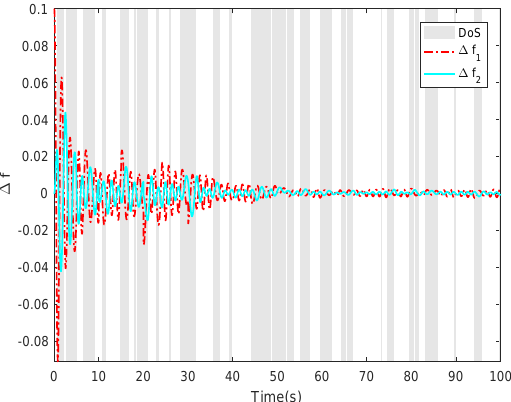
Figure 3. Frequency derivations of two area power system.